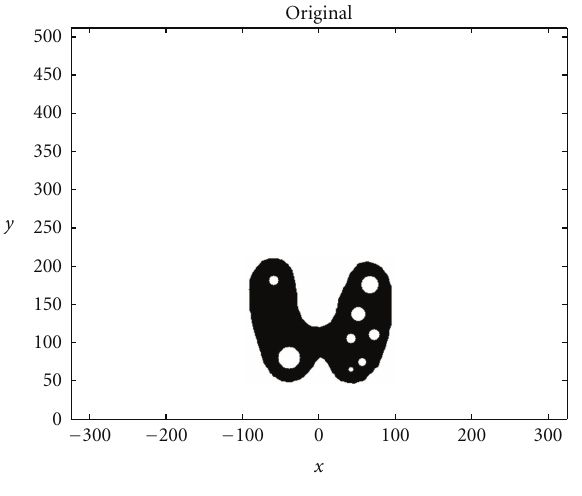
Figure 2: Original thyroid phantom.